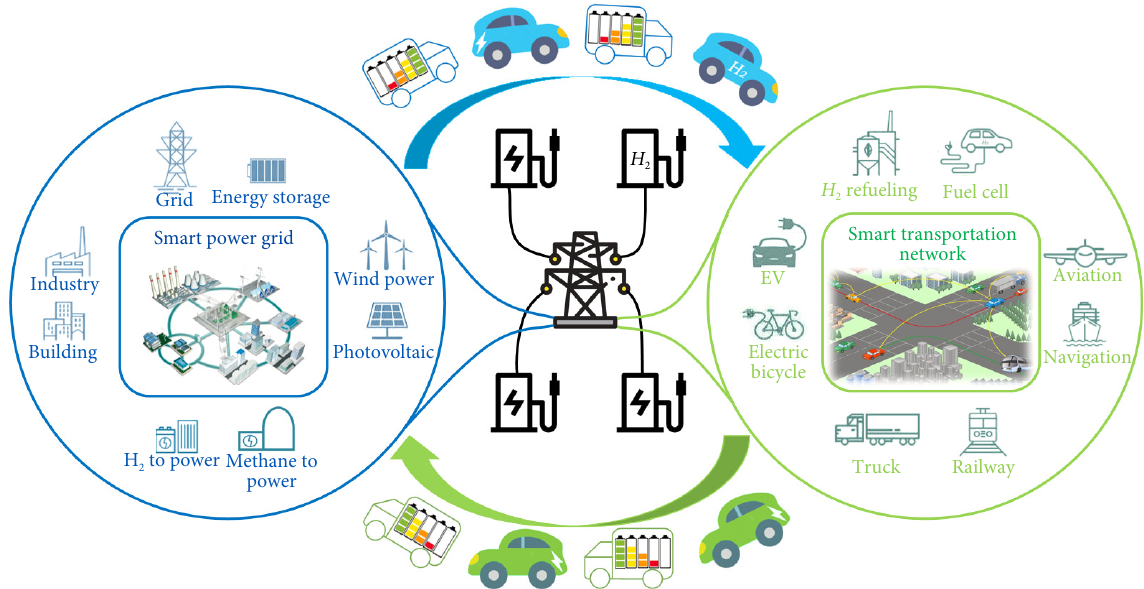
Fig. 3 Schematic of future integrated energy and transportation